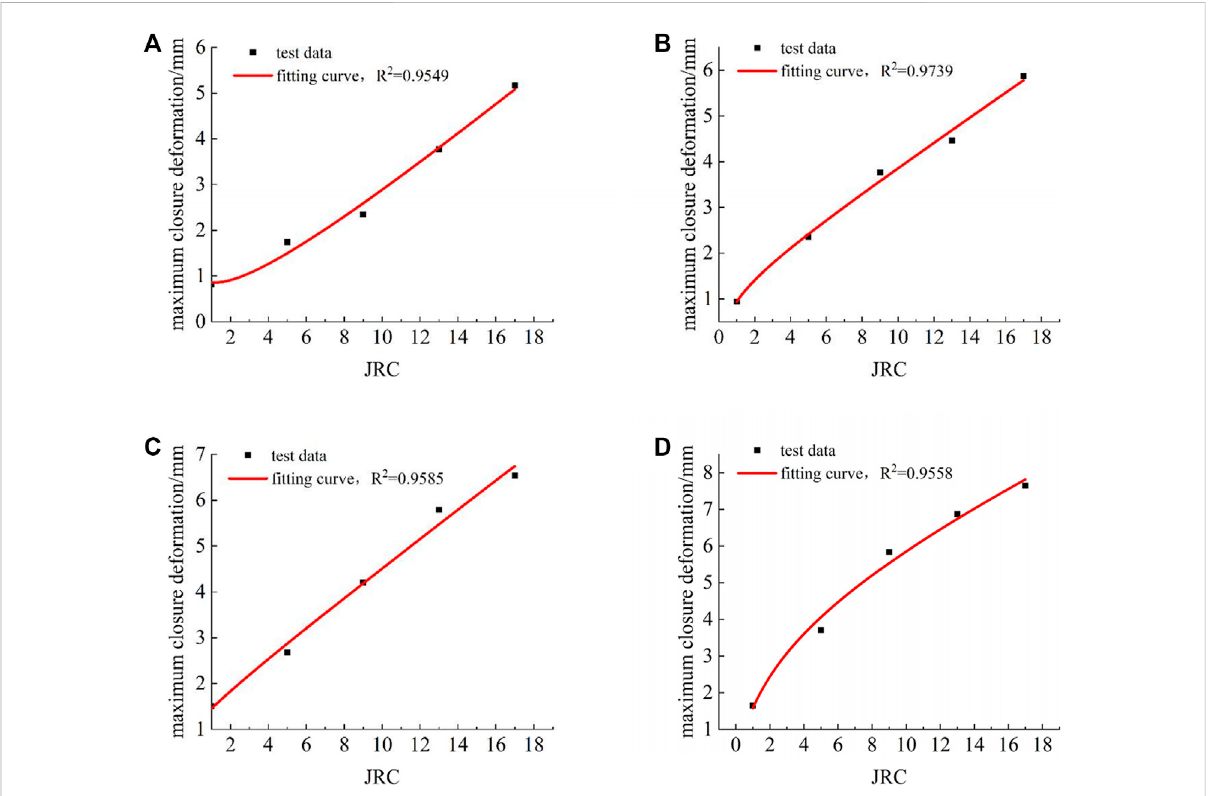
FIGURE 14 Maximum closure deformation-JRC curve under different degrees of fi lling: (A) k=0.5; (B) k=1.0; (C) k=1.5; and (D) k=2.